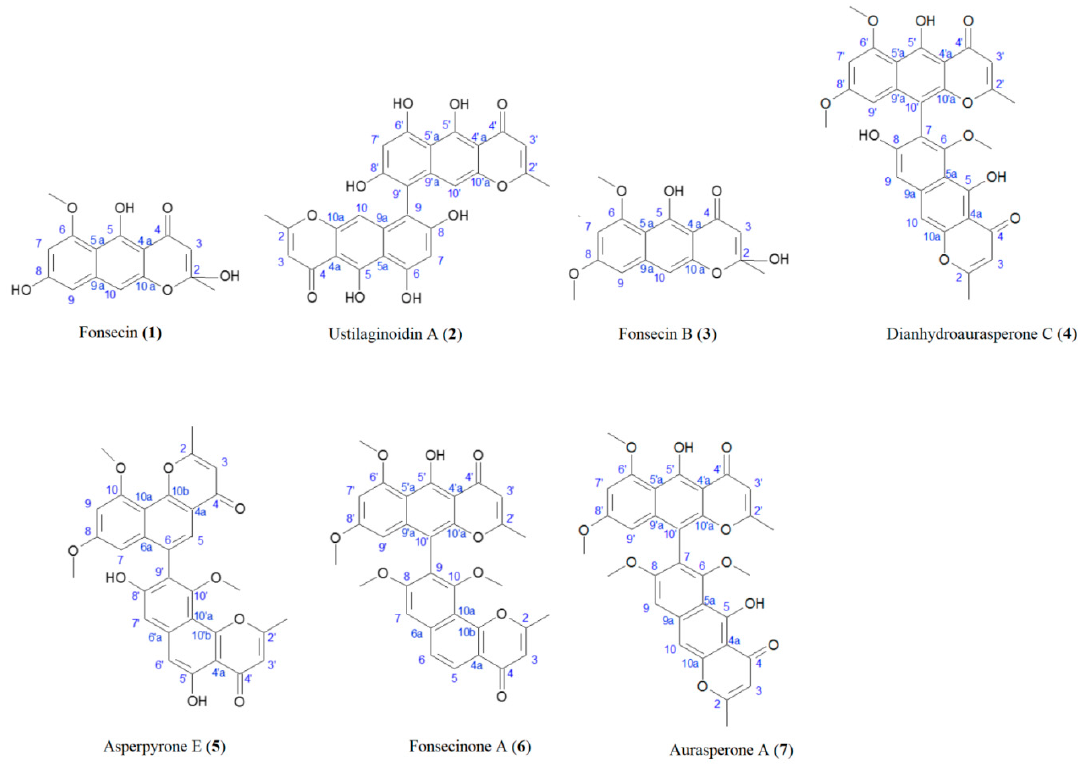
Figure 2. Structures of compounds 1 – 7 and carbon numbering used for NMR assignment.